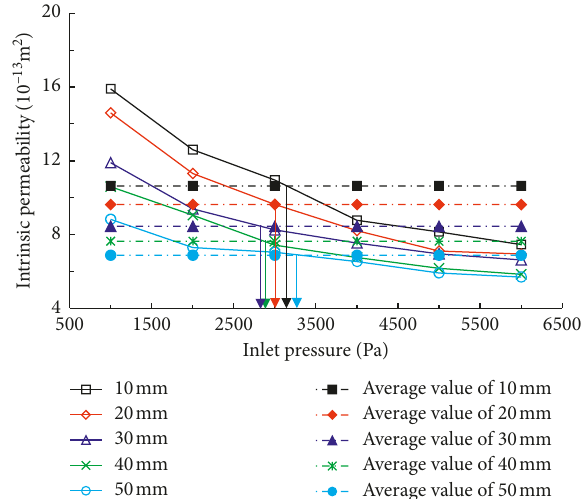
Figure 7: Intrinsic permeability of MSW under different inlet